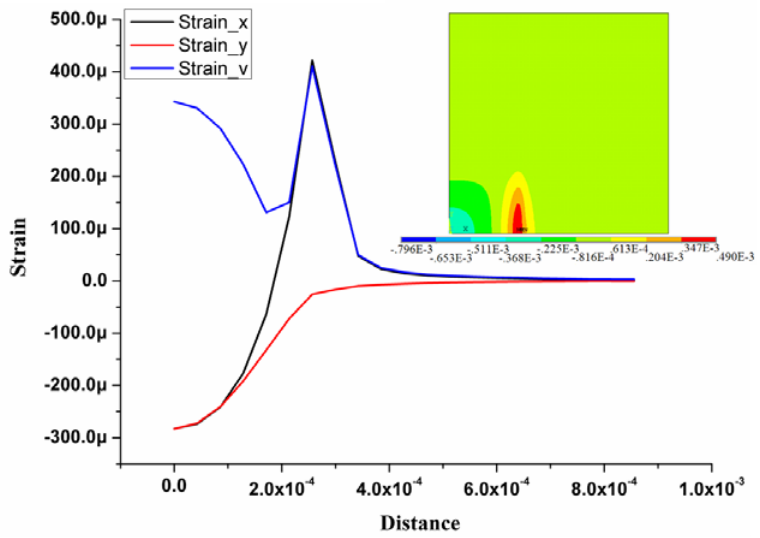
Figure 5. Analytical results of the quarter model of the sensor chip based on